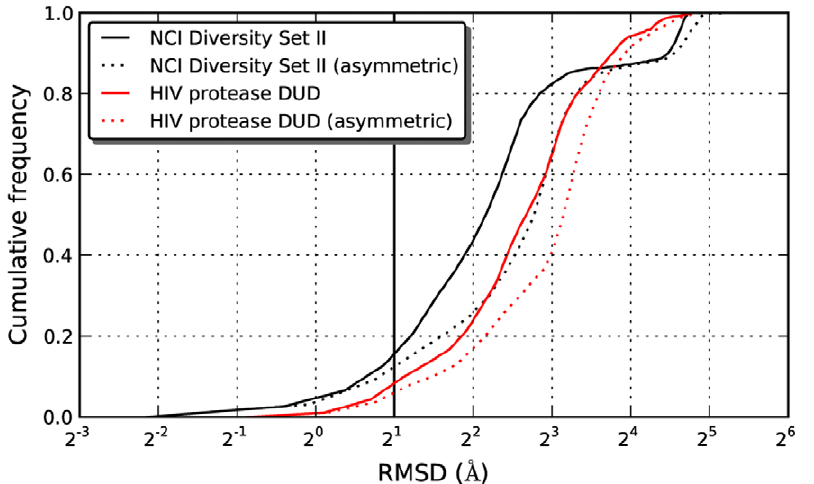
Figure 4. Cumulative RMSD distribution between AD4 and Vina conformations. Differences in the binding conformations predicted by AD4 and Vina were compared using RMSD. As HIV protease is a homodimer, calculations are shown with and without regard for protein’s symmetry. Only a small fraction of compounds fall under the 2 A˚ threshold traditionally used to indicate close agreement in conformational space. doi:10.1371/journal.pone.0011955.g004 PLoS ONE |